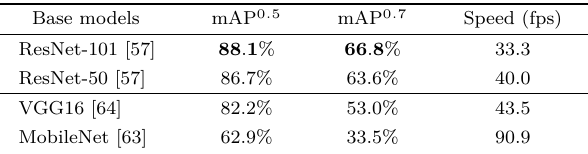
Table 4 Performance of S4Net when using different base models. When we change the default ResNet-50 to ResNet-101, 3.2% improvement is obtained at the cost of a little extra time. Using MobileNet [63] as our base model yields a frame rate of more than 90 fps on a GTX 1080 Ti